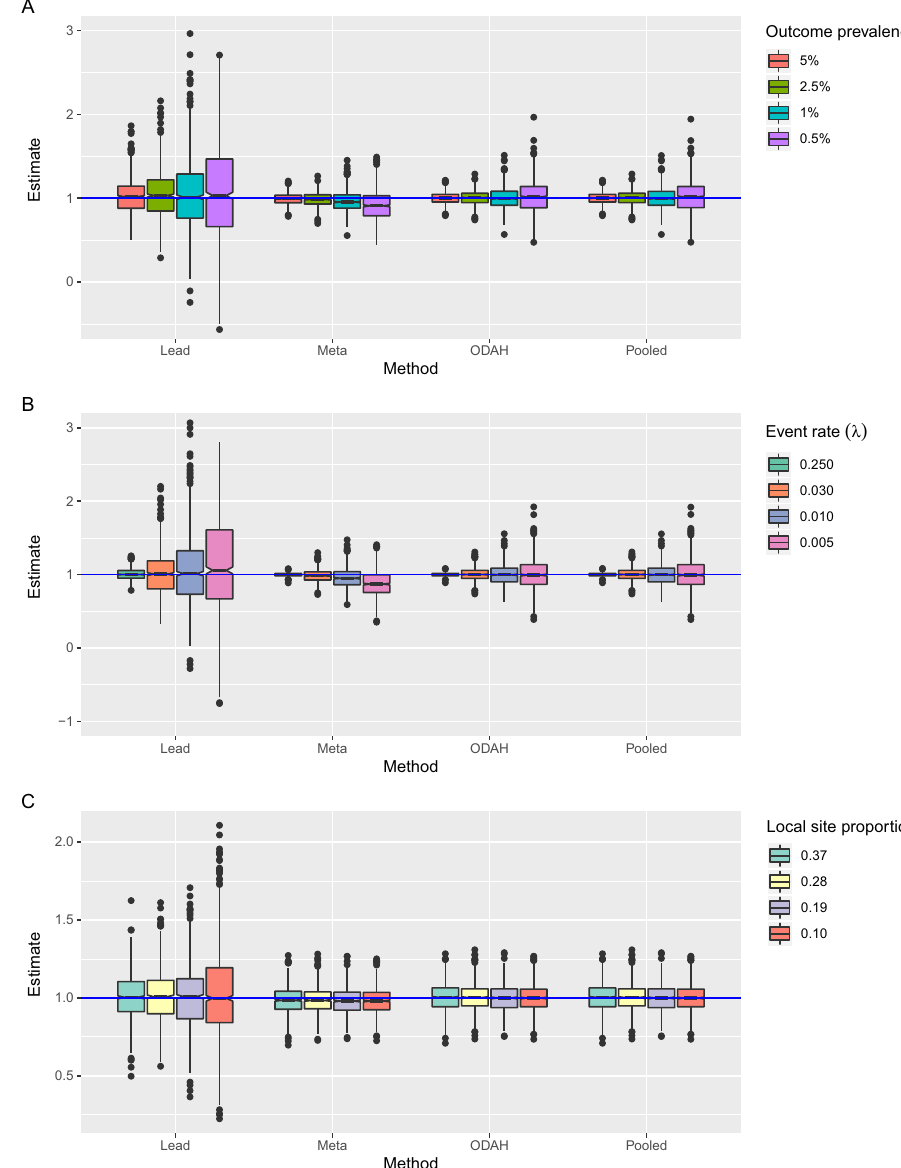
Figure 5. Simulation results for estimating zero-truncated Poisson component covariate γ 2 . ( A ) Results for Setting A, fixing n lead = 20,000 and γ 0 = − 3.6 ( (cid:31) = 0.03 ) while varying outcome prevalence. ( B ) Results for Setting B, fixing n lead = 20,000 and β 0 = − 3.7 (2.5% prevalence) while varying event rate ( (cid:31) ) . ( C ) Results for Setting C, fixing β 0 = − 3.7 (2.5% prevalence) and γ 0 = − 3.6 ( (cid:31) = 0.03 ) while varying proportion of observations in lead site. Horizontal blue line represents true value of γ 2 = 1